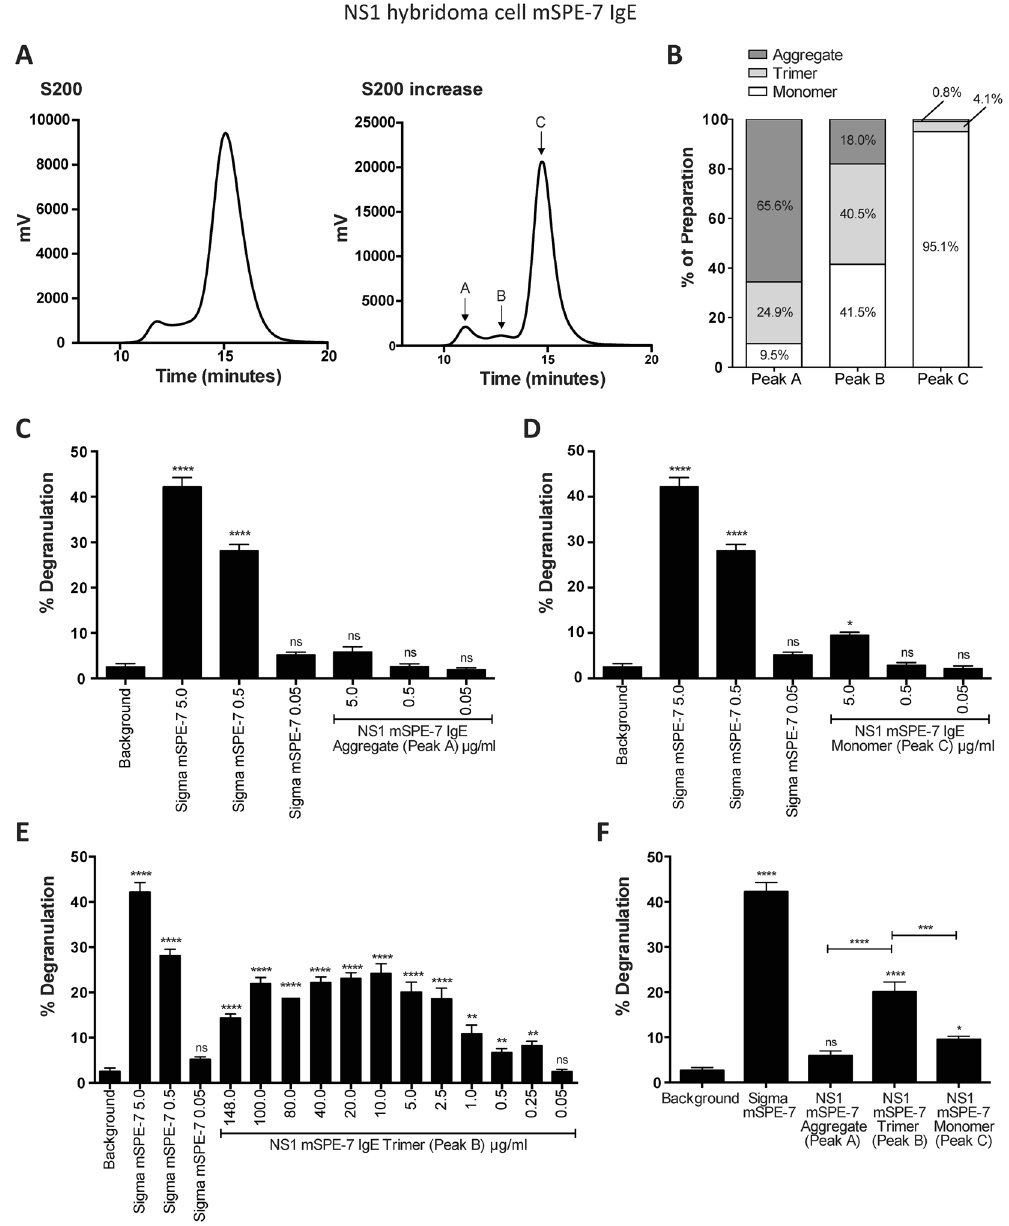
Figure 4. mSPE-7 IgE trimer displays cytokinergic activity. ( A ) Improved size fractionation of mSPE-7 IgE was achieved with a Superdex 200 Increase HPLC column. ( B ) SEC-MALLS analysis of peaks A, B and C from the column determined the percentage of high molecular weight aggregates, trimers and monomers in Peaks A, B and C, respectively. The percentages of each in the three fractions are indicated. ( C ) No RBL-SX38 cell degranulation above buffer background control was induced by incubation with the IgE in peak A preparation (65.6% aggregated IgE), in the absence of antigen. ( D ) Significant, but low-level degranulation, compared to buffer background control was induced by incubation with 5 μ g/ml of the IgE in peak C (95.1% monomeric IgE and 4.1% trimeric IgE) in the absence of antigen. Incubation with unpurified Sigma mSPE-7 IgE, in absence of antigen, resulted in significant RBL-SX38 degranulation compared to buffer background control in both experiments. ( E ) Significant RBL-SX38 cell degranulation was induced by incubation with NS1 mSPE-7 IgE trimer in the absence of antigen (peak B in purification profile). ( F ) Degranulation induced by peaks A, B and C at 5 μ g/ml is compared. Means of 3 independent experiments ± SEM are shown. Statistically significant difference to background control (unless otherwise indicated) was determined by one-way ANOVA with Dunnett’s post-test; **** P < 0.0001, ** P = 0.001 to 0.01, ns P >